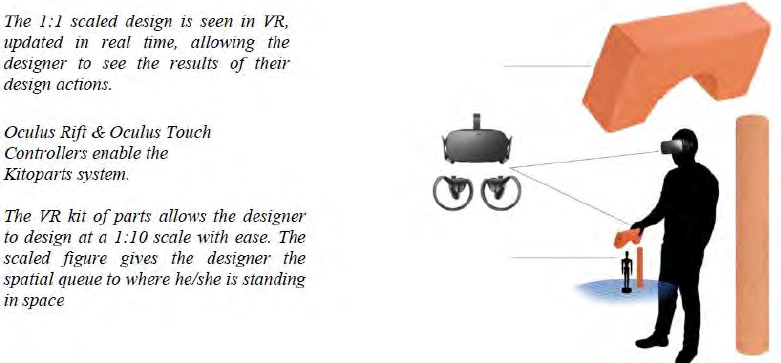
Figure 6. Kitoparts modeling environment and